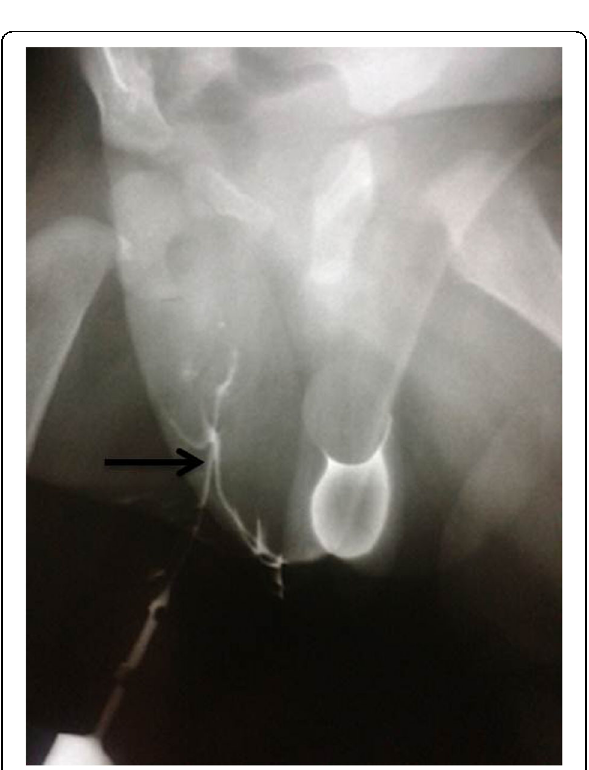
Fig. 18 Peri-anal fistula in an infant. Peri-anal fistulogram showing the short fistulous tract